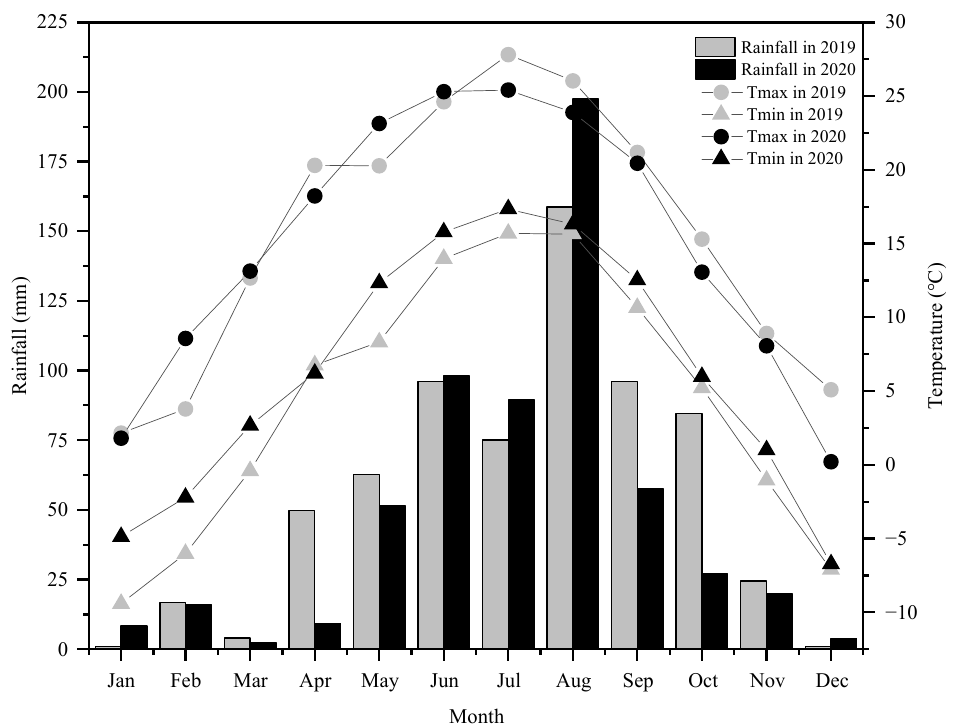
Figure 1. The monthly rainfall, maximum (Tmax) and minimum air temperatures (Tmin) in 2019 and 2020. Table 1. Basic soil feature at the experimental site.